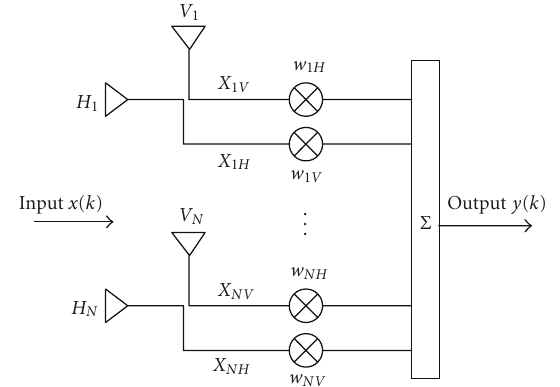
Figure 1: Block diagram of the dual-polarized antenna array